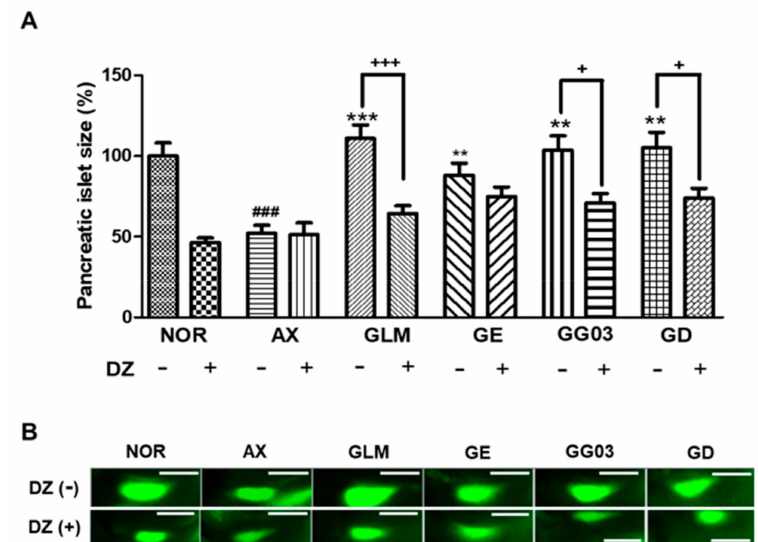
Figure 7. E ff ect of ginger extract (GE), steamed ginger extract (GG03) and 1-dehydro-6-gingerdione (GD) on K ATP channels in alloxan-induced diabetic zebrafish: action of diazoxide (DZ) in the e ffi cacy of GE, GG03 and GD. ( A ) Pancreatic islet size of each group. ( B ) Pancreatic islet images. ( ### p < 0.001; compared to NOR), (* p < 0.05, ** p < 0.01, *** p < 0.001; compared to AX), ++ p < 0.05, +++ p <